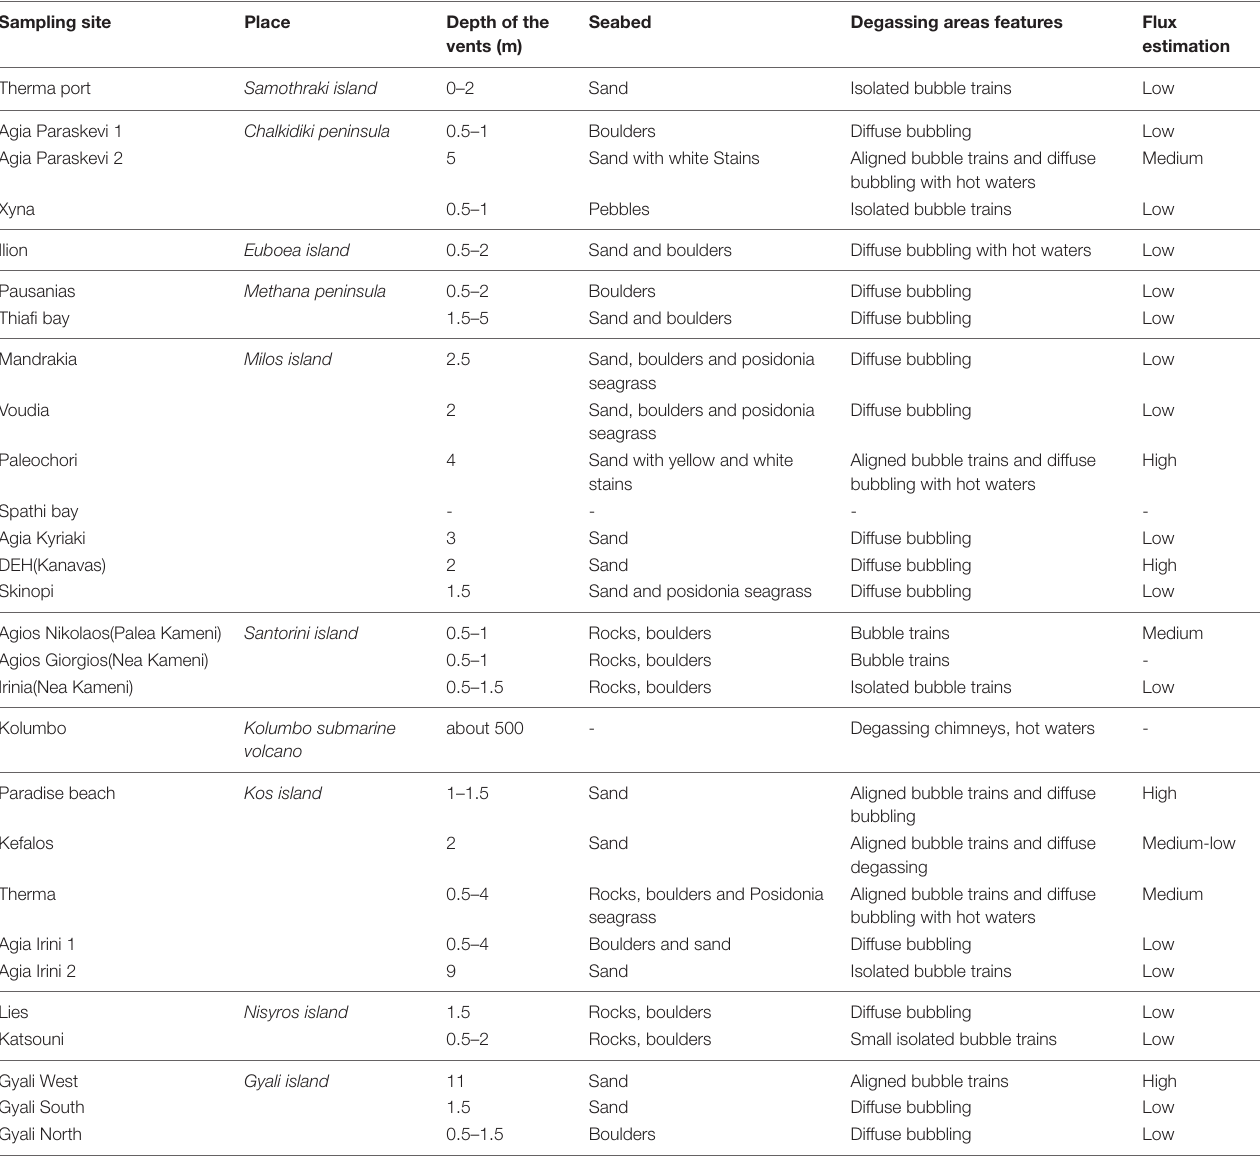
TABLE 1 | List and general characteristics of the underwater degassing areas. Sampling